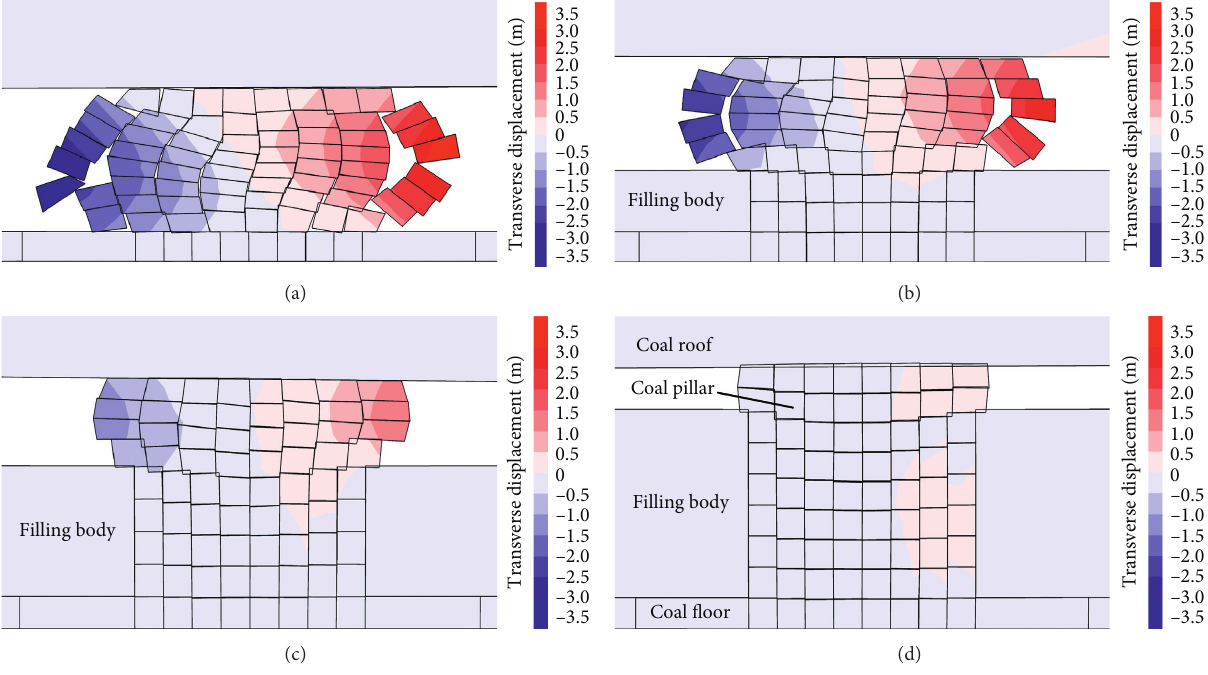
Figure 7: Deformation of No. 2 coal pillar in different schemes.